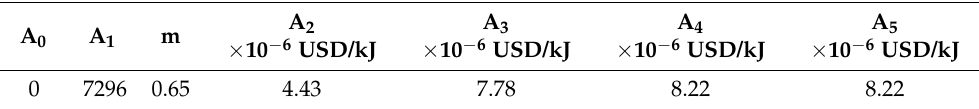
Table 5. Economic factor values for heat exchanger equipment and